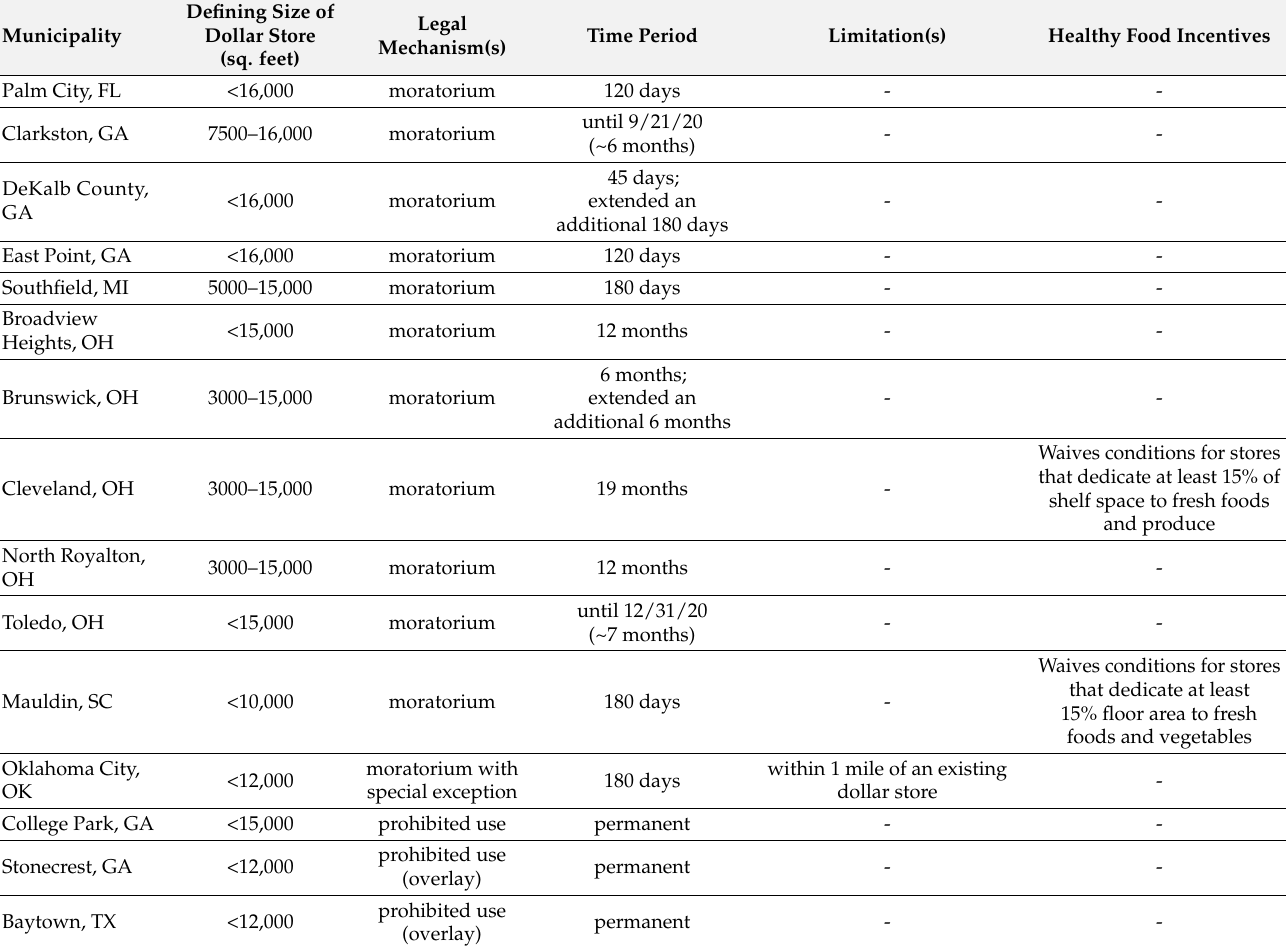
Table 3. Summary of relevant policy provisions (N =